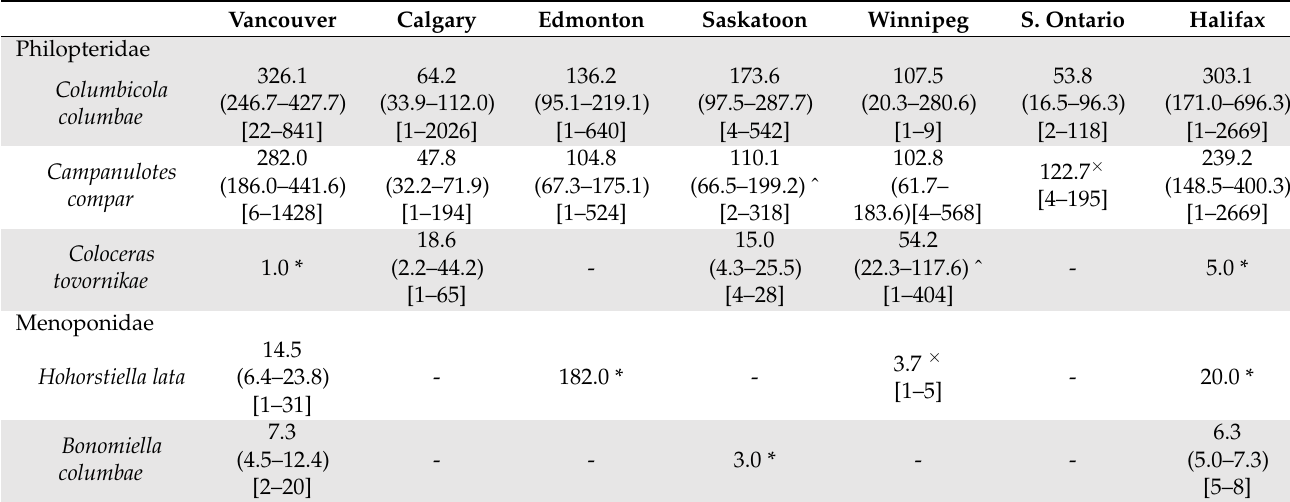
Figure 4. Prevalence of feather lice: ( A ) Columbicola columbae, ( B ) Campanulotes compar, ( C ) Coloceras tovornikae , ( D ) Hohorstiella lata, and ( E ) Bonomiella columbae infesting Columba livia sampled from seven locations across Canada, 95% confidence intervals. Sample sizes refer to number of C. livia examined from each location. Table 3. Mean intensity of lice found on Columba livia collected from seven locations across Canada. 95% confidence intervals in parentheses and ranges in